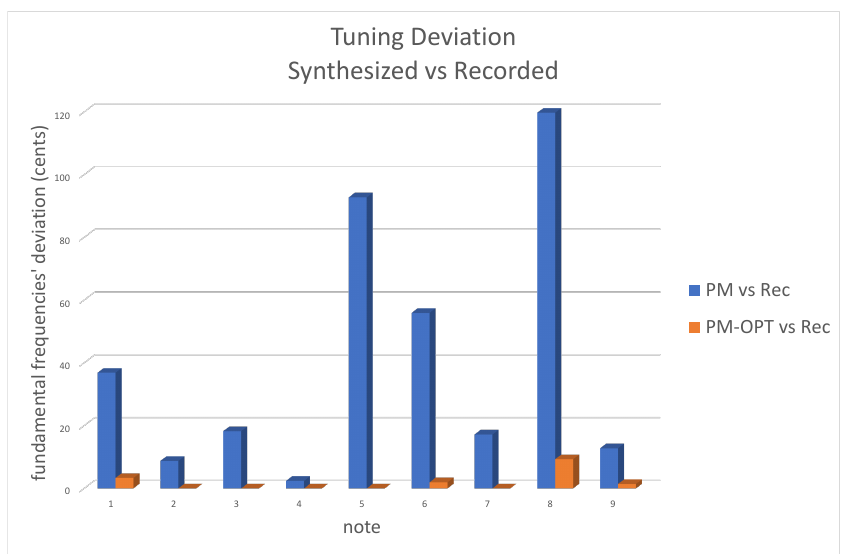
Figure 4. The average absolute deviation of the fundamental frequency of the synthesized and the recorded signals in cents in various notes for PM (blue) and PM with optimal correction factors